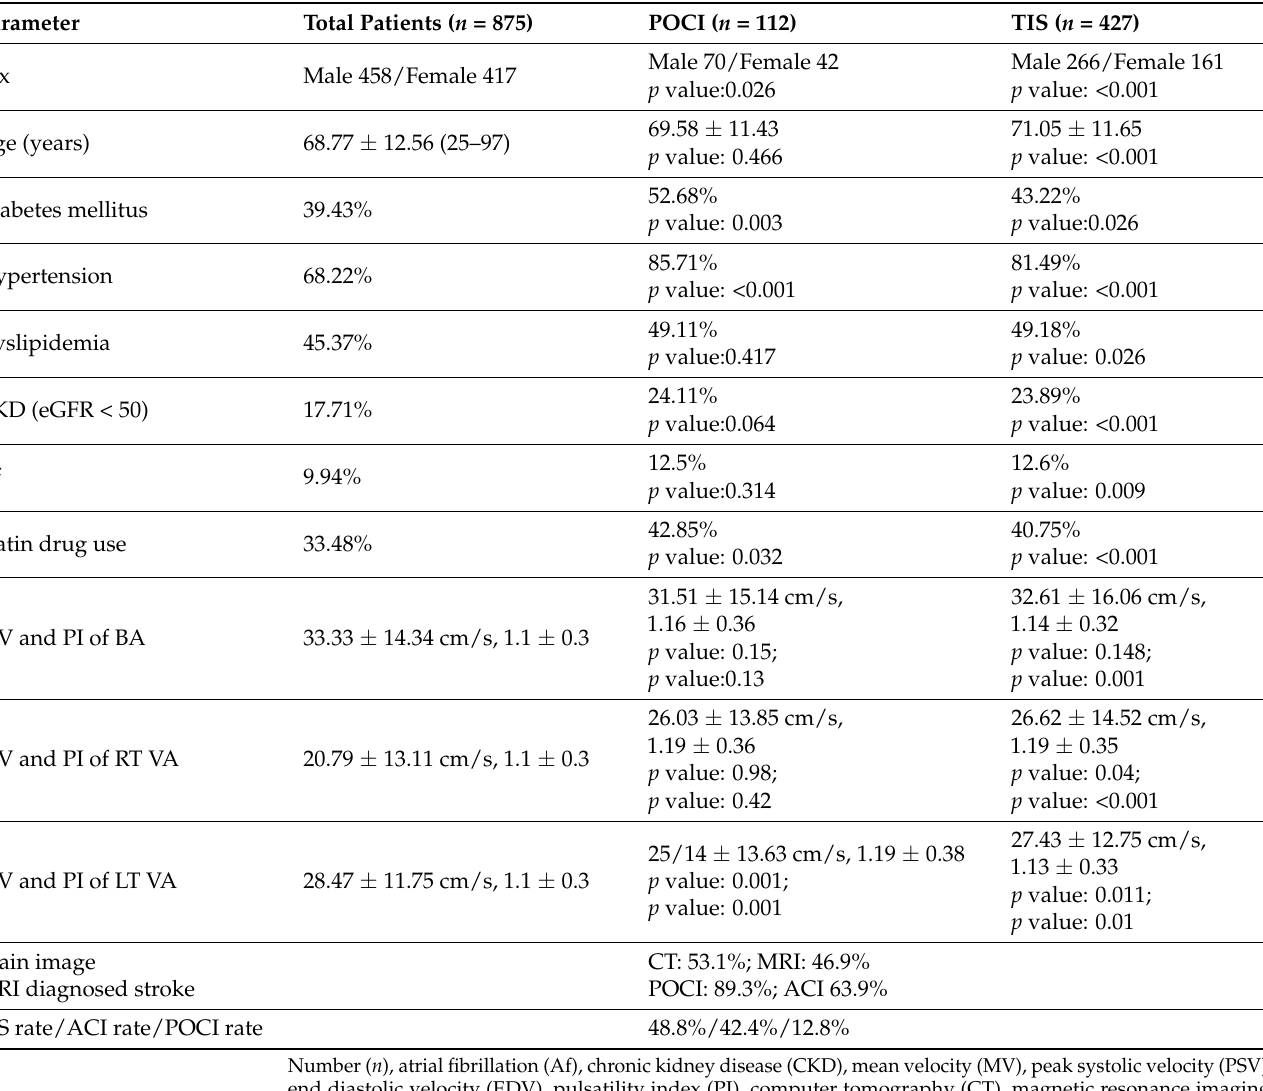
Table 1. Characteristics of